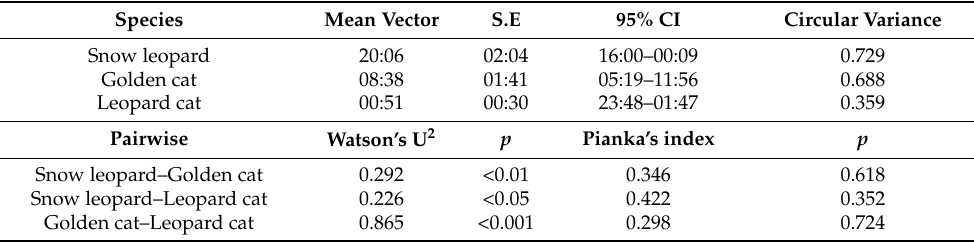
Table 3. Circular statistics of temporal activity pattern, pairwise difference in activity patterns (Watson’s U 2 test statistics) and temporal overlap (Pianka’s overlap index) among felid species ( p is the level of significance in the test